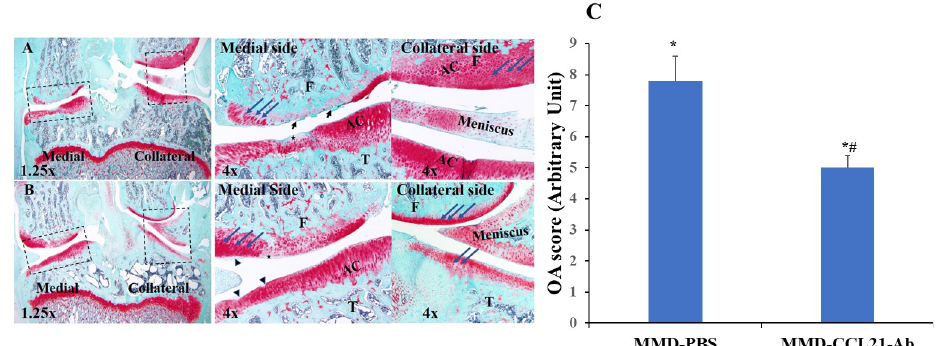
Fig 7. Treatment with CCL21 antibody ameliorates MMD-induced PTOA development in rat knees. Representative images from histology sections isolated, at 4-wks post-surgery from MMD knees treated with PBS ( A ) showing irregularities, fibrillations at the articular cartilage (black arrows) and loss of safranin-o staining (black stars) at the medial side. The MMD-knees treated with10 μ g CCL21-Ab ( B ), showing fewer irregularities and thinner fibrillations (black arrowheads) at the superficial zone of the articular cartilage and less loss of safranin-O staining (black stars). Bleu arrows show tide mark line. Sections were stained with Safranin-O/fast green and observed using microscope objectives 1.25x ( A and B ) and 4x ( right panels ). T. tibia plateau and F. femur condyle. AC for articular cartilage. Cartilage damage quantification ( C ). Histopathology Evaluation of MMD-operated knees at Four Week- Post-Surgery, for PBS and CCL21-Ab treated rats. Data are expressed as mean ± SE, n = 6–8, � P < 0.05 vs controls, #P < 0.05 vs